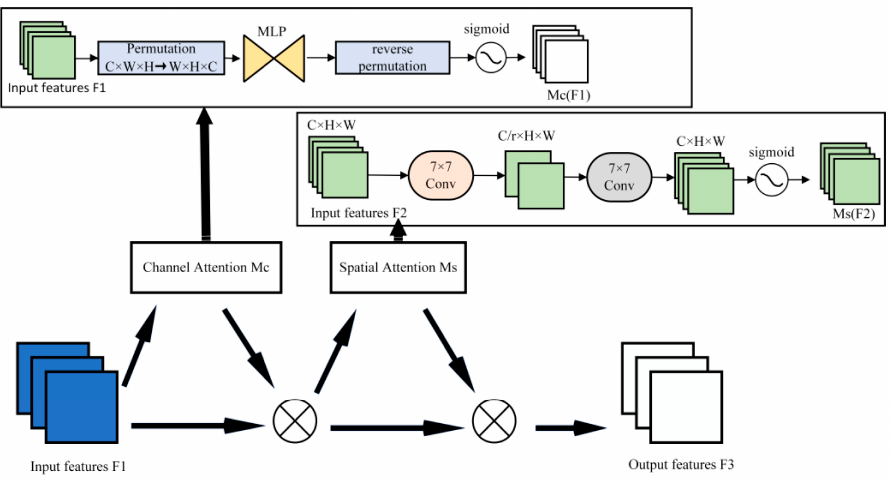
Figure 3. GAM module